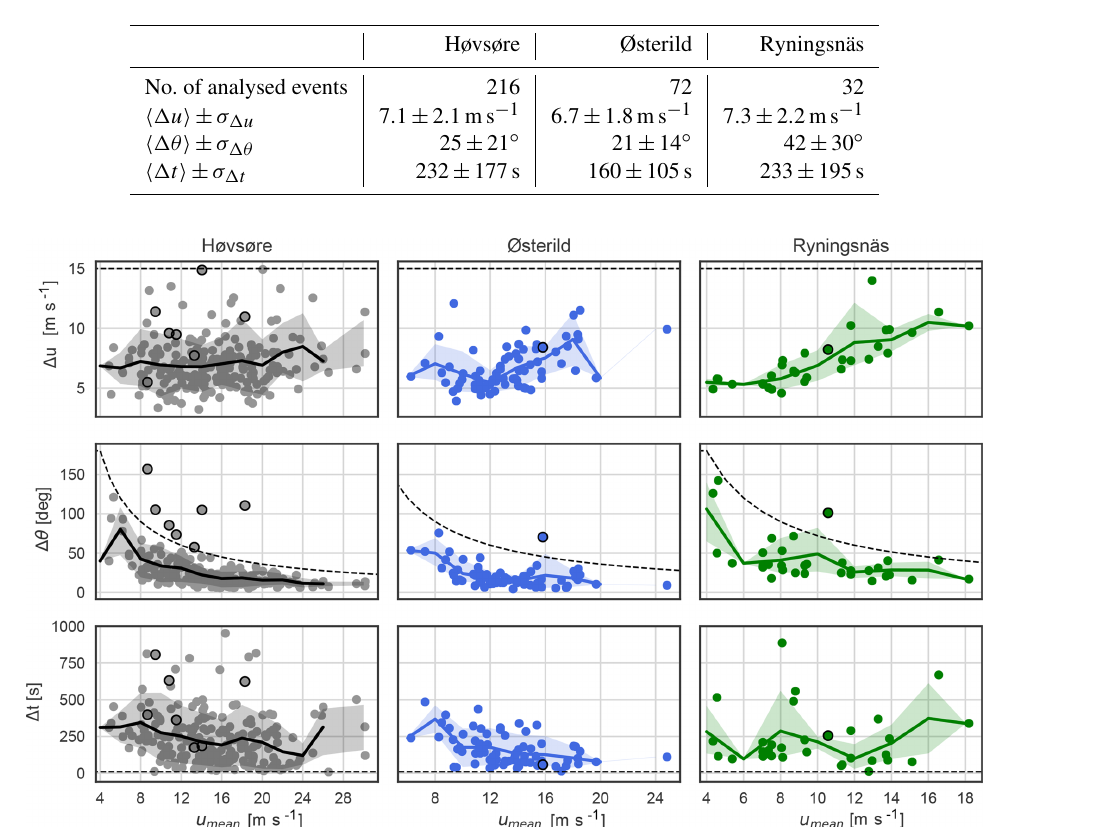
Figure 8. The detected amplitudes ( (cid:49)u ), direction changes ( (cid:49)θ ), and rise times ( (cid:49)t ) as functions of the mean wind speed at the different sites: Høvsøre (grey), Østerild (blue), and Ryningsnäs (green). The plots share the primary axis (abscissa) per column, and they share the secondary axis (ordinate) per row. The shaded area indicates events between the 10th percentile and 90th percentile for each wind speed bin, with bin width 2ms − 1 . The black dashed lines show the ECD